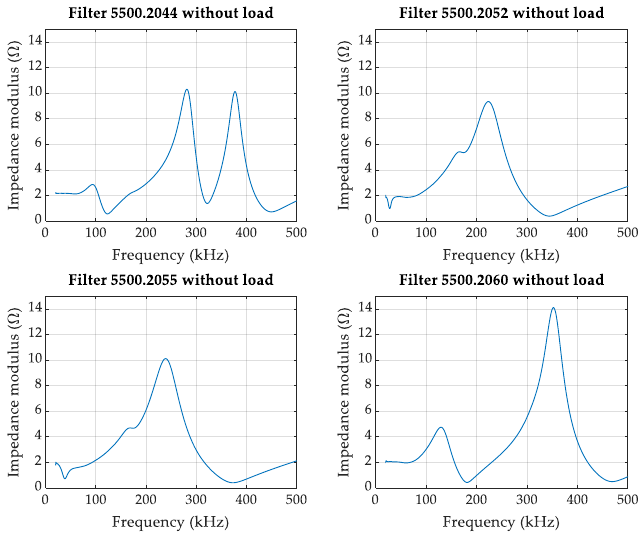
Figure 5. Impedance modulus of the four EMC filters connected to the setup, without connecting a load in L’-N’.